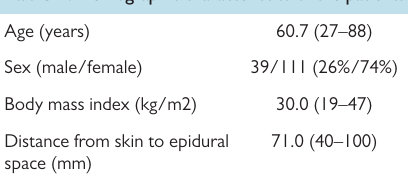
Table 1. Demographic characteristics of the